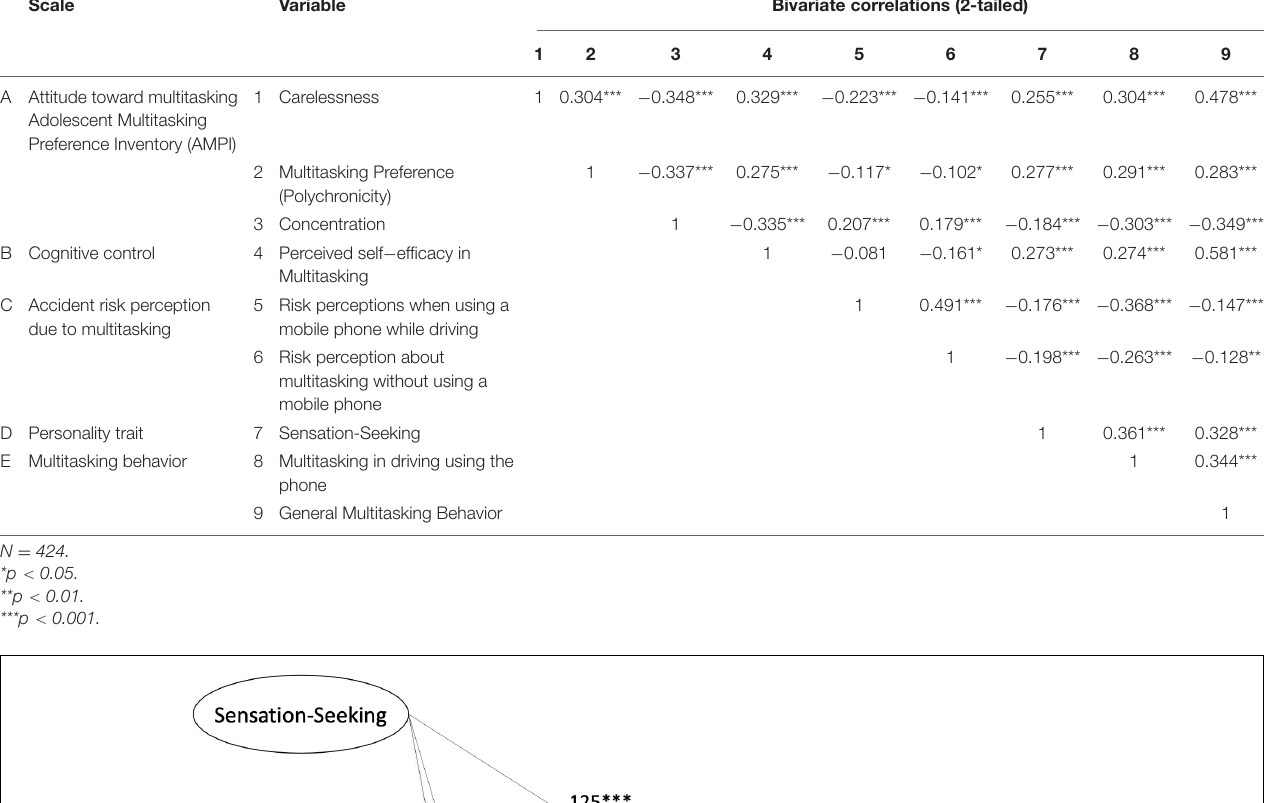
Error of Approximation (RMSEA) = 0.170] and needed to be adjusted. Therefore, several modifications were made. First, non- significant and very low paths were set to zero, eliminating some variables. Specifically, Attitude toward Concentration and Risk